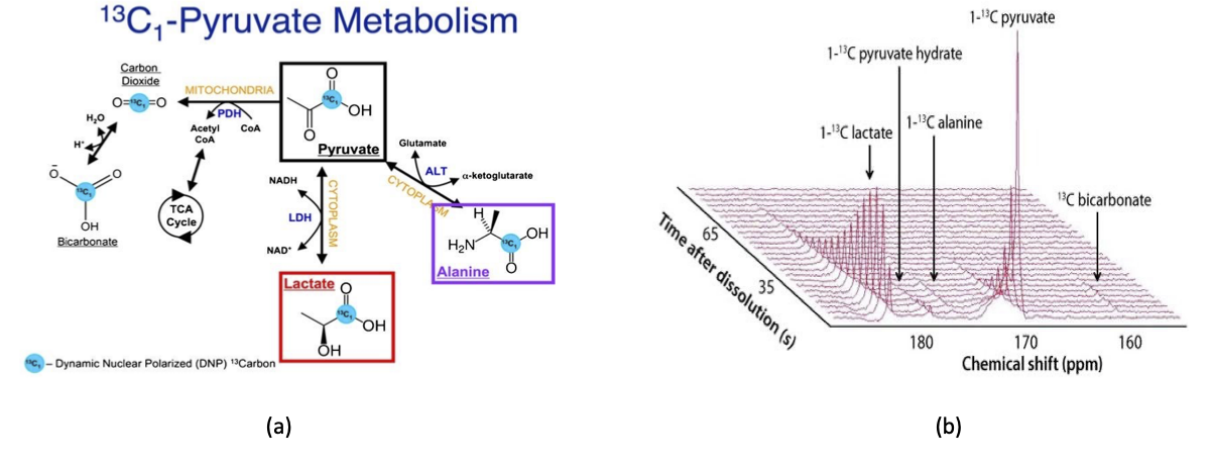
Figure 1. (a) Schematic showing pyruvate metabolism inside a cell. The [1-13C] pyruvate can be converted to 13C-lactate, 13C-alanine, and 13C-bicarbonate in the presence of enzymes lactate dehydrogenase-A (LDHA), alanine transferase (ALT), and pyruvate decarboxylase, respectively. (b) Downstream products of pyruvate metabolism such as lactate and alanine can be imaged using hyperpolarized magnetic resonance. A 3D, real-time readout of the signals, as shown here, can be created using standard software such as